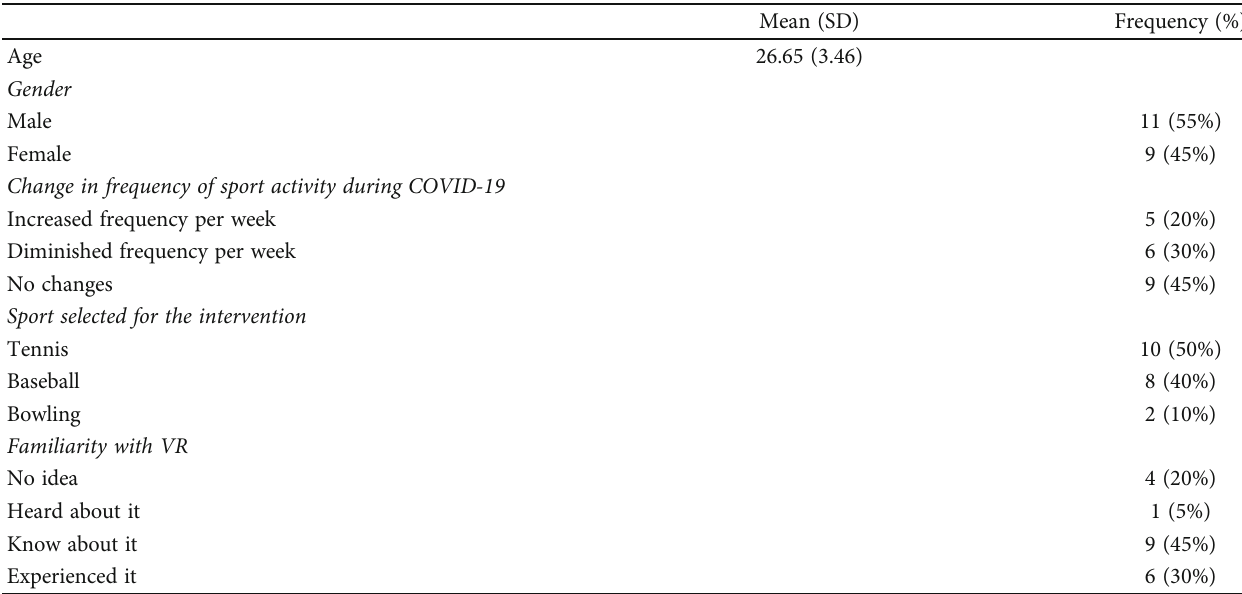
Table 1: Participant characteristics ( n = 20